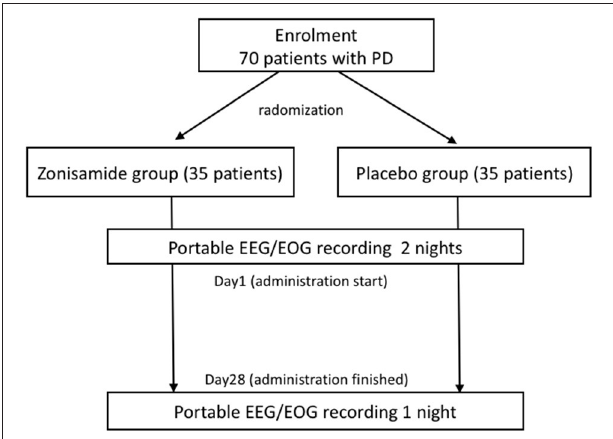
FIGURE 1 | Flowchart of the study showing randomized control